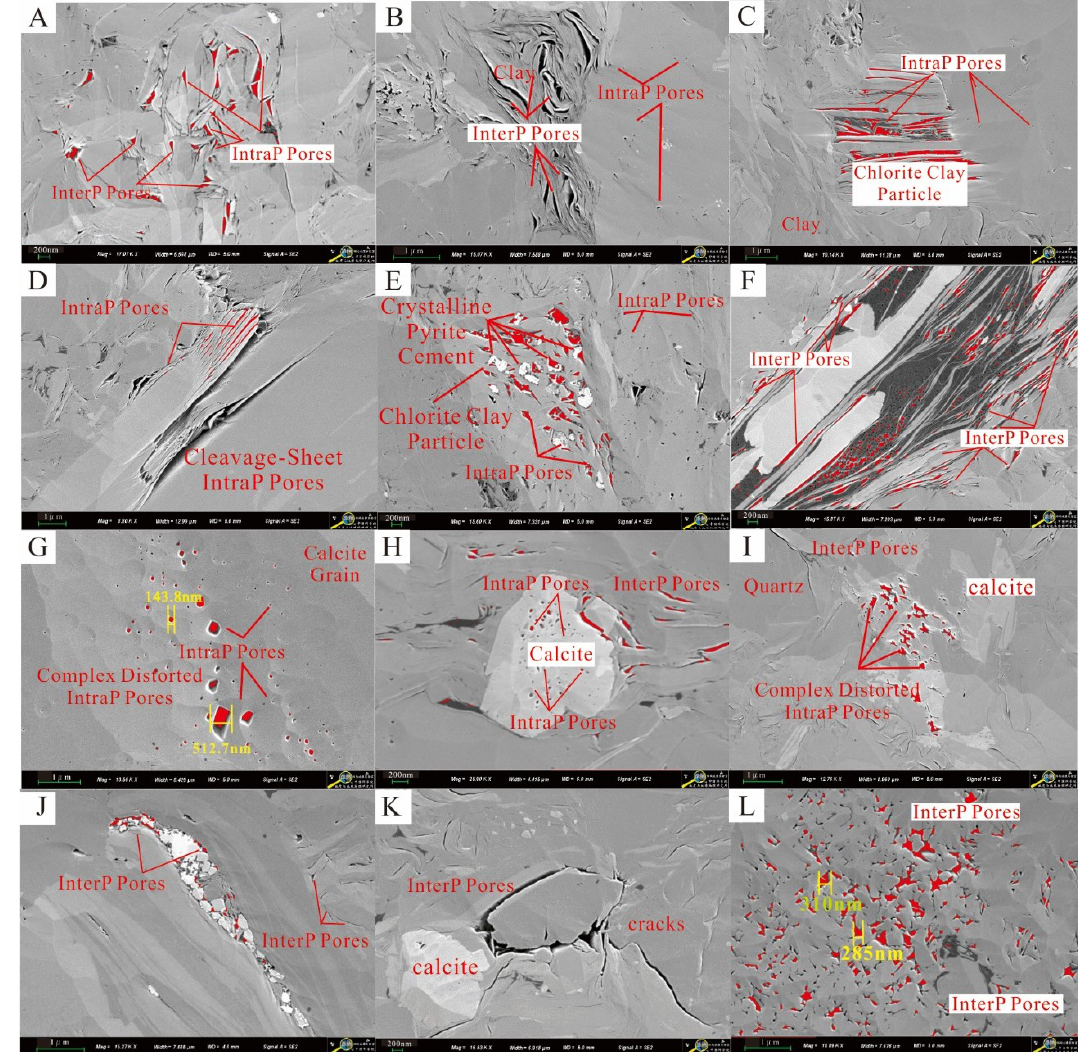
Figure 5. FE-SEM images showing inorganic mineral pores in the Shahezi shales in CFD. ( A – F ) Slit-like interP pores and intraP pores in clay composites. ( G – I ) IntraP pores hosted in siliceous and calcareous minerals. ( J ) InterP pores are filled with pyrite framboids. ( K ) Micro-cracks developed at the edge of inorganic mineral grains. ( L ) Complex intergranular pores between quartz grains.